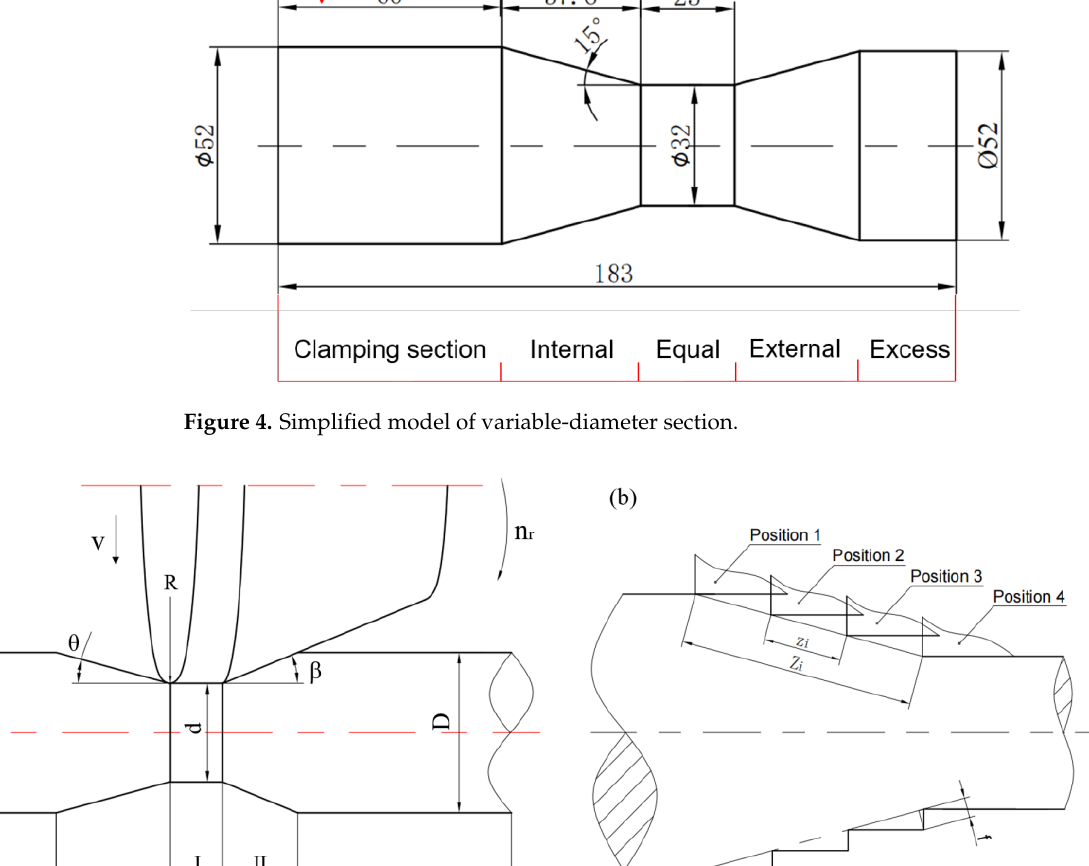
Figure 5. The internal variable-diameter section ( a ) forming stage and ( b ) lead analysis of processing path.